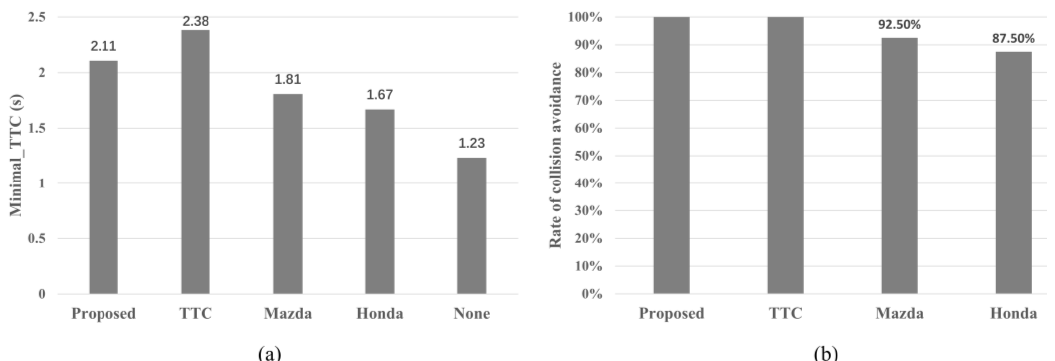
Figure 7. The objective utility of the proposed model expressed in terms of the minimal TTC ( a ) and the rate of collision avoidance ( b ).